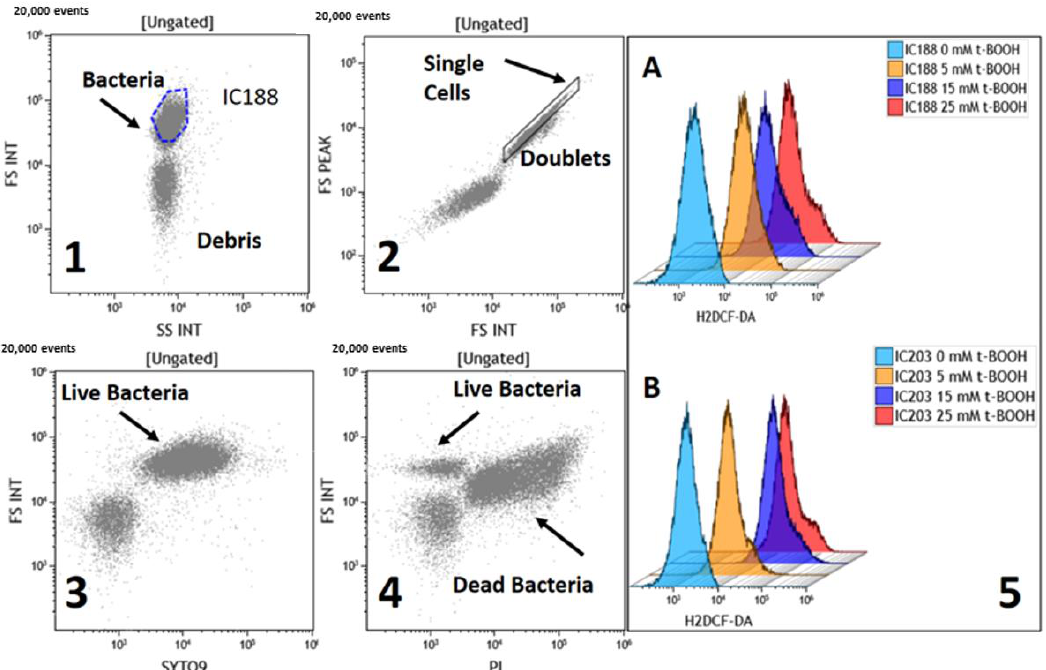
Figure 1. Scheme of the flow cytometric criteria to identify and gate single live bacteria for the analysis of the intracellular level of ROS. ( 1 ) shows the light-scatter features (FS Int vs. SS Int) allowing us to define the gate for bacteria, distinguished from debris. ( 2 ) shows the gate created to include only single cells in the further analysis. ( 3 , 4 ) confirm that the light-scatter features of the events in the gate “bacteria” in ( 1 ) identify live bacteria as events able to be stained with SYTO-9 ( 3 ); data from an untreated sample) and to become labelled with PI in conditions of cytotoxicity ( 4 ); data from cells treated with 10 mM t-BOOH). ( 4 ) also shows that the fraction of live cells in toxic-treated samples can be identified and gated for analyzing intracellular fluorescence associated with ROS generation, as shown in ( 5 ) for two samples of wild-type (IC188, ( A )) and oxyR -deficient (IC203, ( B )) E. coli strains exposed to different concentrations of t-BOOH.